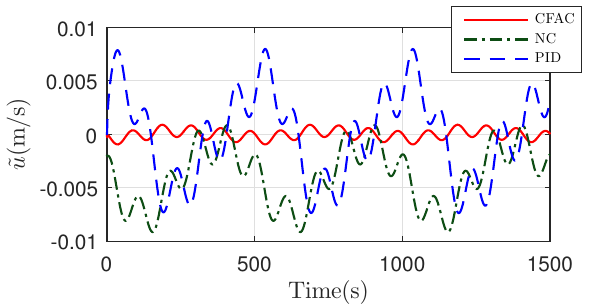
Figure 4. Velocity tracking performance in submerging motion with a variable velocity and constant pitch angle command.